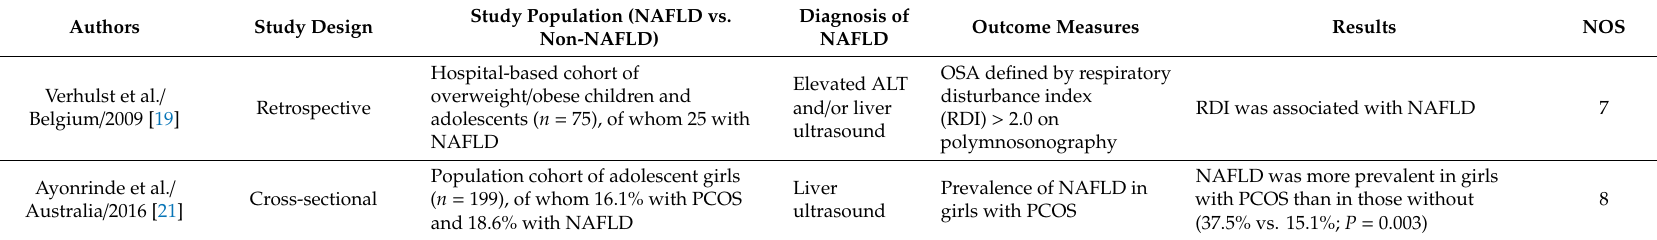
Table 6. Study characteristics for nonalcoholic fatty liver disease and obstructive sleep apnea as well as well as polycystic ovary